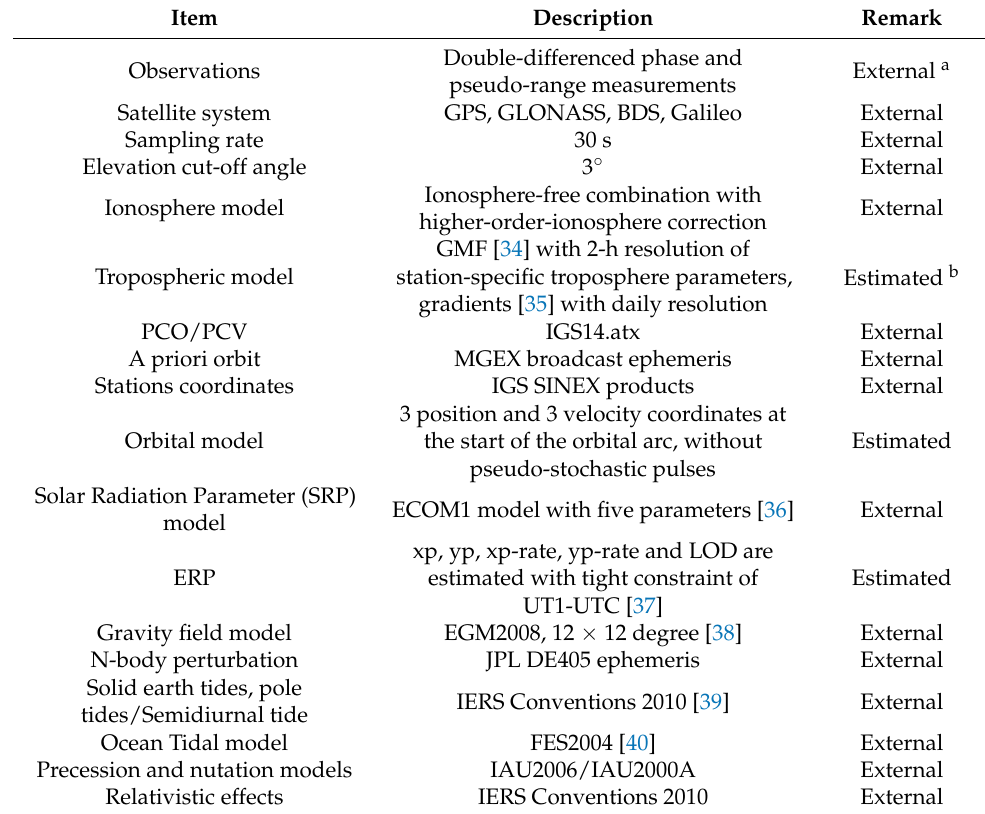
Table 2. Multi-GNSS ultra-rapid orbit determination